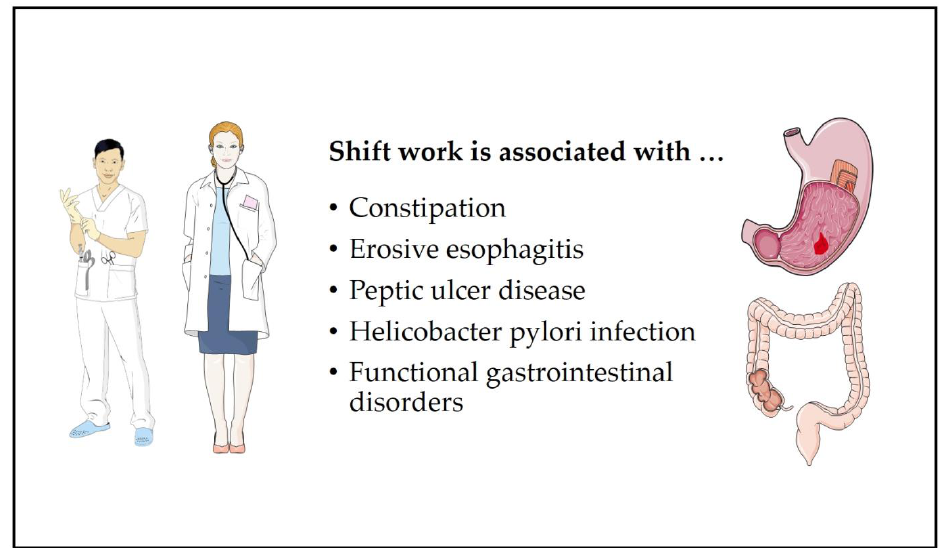
Figure 1. Shiftwork and its associations with gastrointestinal disorders, based on [12–16]. Modified from Servier Medical Art database by Servier (www.smart.servier.com (accessed on 8 March 2022); Creative Commons